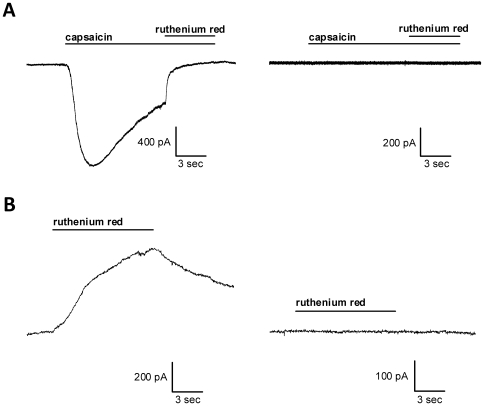
Capsaicin-induced and capsaicin-independent currents are blocked by ruthenium red in TRPV1-transfected neurons.(A) Examples of TRPV1-transfected (left panel) and non-transfected (right panel) neurons exposed to acute application of 500 nM capsaicin for 15 s with 10 µM ruthenium red added during the last 5 s. TRPV1-transfected neurons, but not non-transfected neurons, respond to capsaicin with a robust current that is blocked by ruthenium red. (B) Examples of TRPV1-transfected (left panel) and non-transfected (right panel) neurons exposed to acute application of 10 µM ruthenium red in the absence of capsaicin. Leaky (more than −200 pA standing inward current) TRPV1-transfected neurons reliably responded to ruthenium red while non-leaky TRPV1-transfected neurons and non-transfected neurons did not.